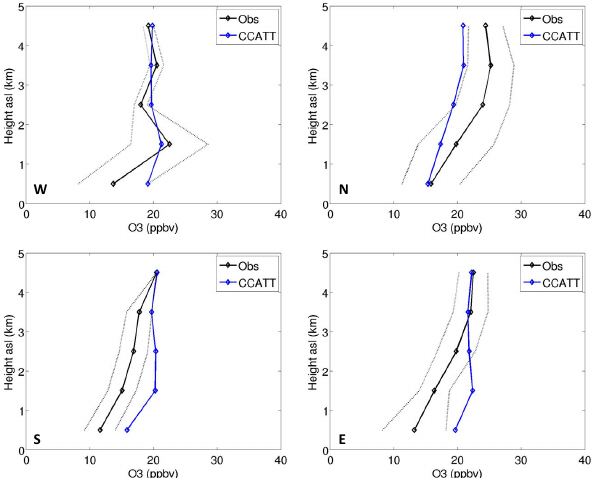
Fig. 6. Vertical profiles (regional medians, 1000 m blocks) for O 3 from CCATT-BRAMS model, compared to observations disaggre- gated by the E, W, N and S regions of Manaus.